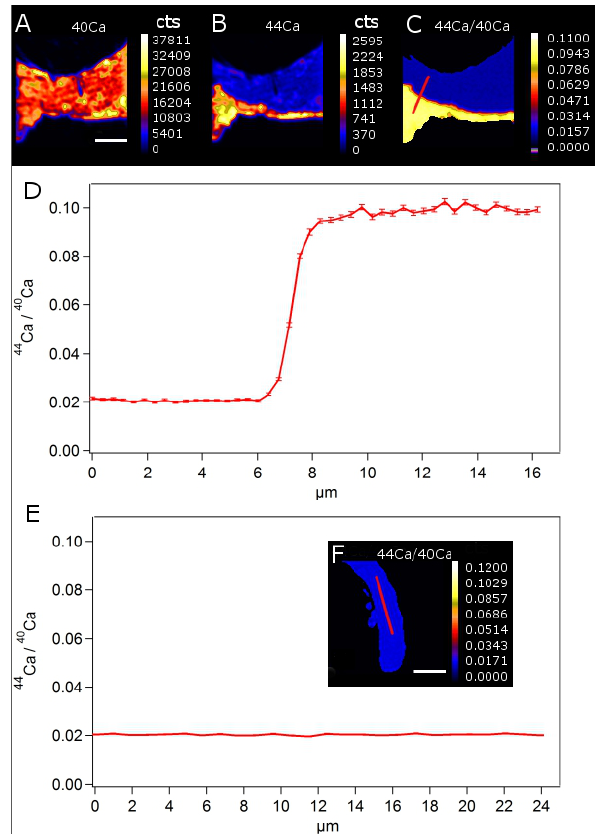
Fig. A1. (A) and (B) show examples of individual NanoSIMS maps in 40 Ca and 44 Ca, respectively, from the Foraminifera exhibited in Fig. 2d. The 40 Ca map is flat, whereas the 44 Ca map shows clear enrichment in the part of the test formed during the labeling ex- periment. (C) shows the 44 Ca/ 40 Ca ratio map in which blue color signifies a normal 44 Ca/ 40 Ca ratio of 0.02 and yellowish color sig- nifies a 44 Ca/ 40 Ca ratio enhanced by a factor of 5 (i.e., a ratio of 0.10) due to the 44 Ca enrichment of the seawater during cham- ber formation. (D) shows the 44 Ca/ 40 Ca profile extracted from the 44 Ca/ 40 Ca ratio map in (C) . (E) shows a 44 Ca/ 40 Ca profile extracted from the Foraminifera test exhibited in Fig. 2b (cf. 2F) demonstrating that the blue color signifies a natural 44 Ca/ 40 Ca ra- tio. Scale bars are